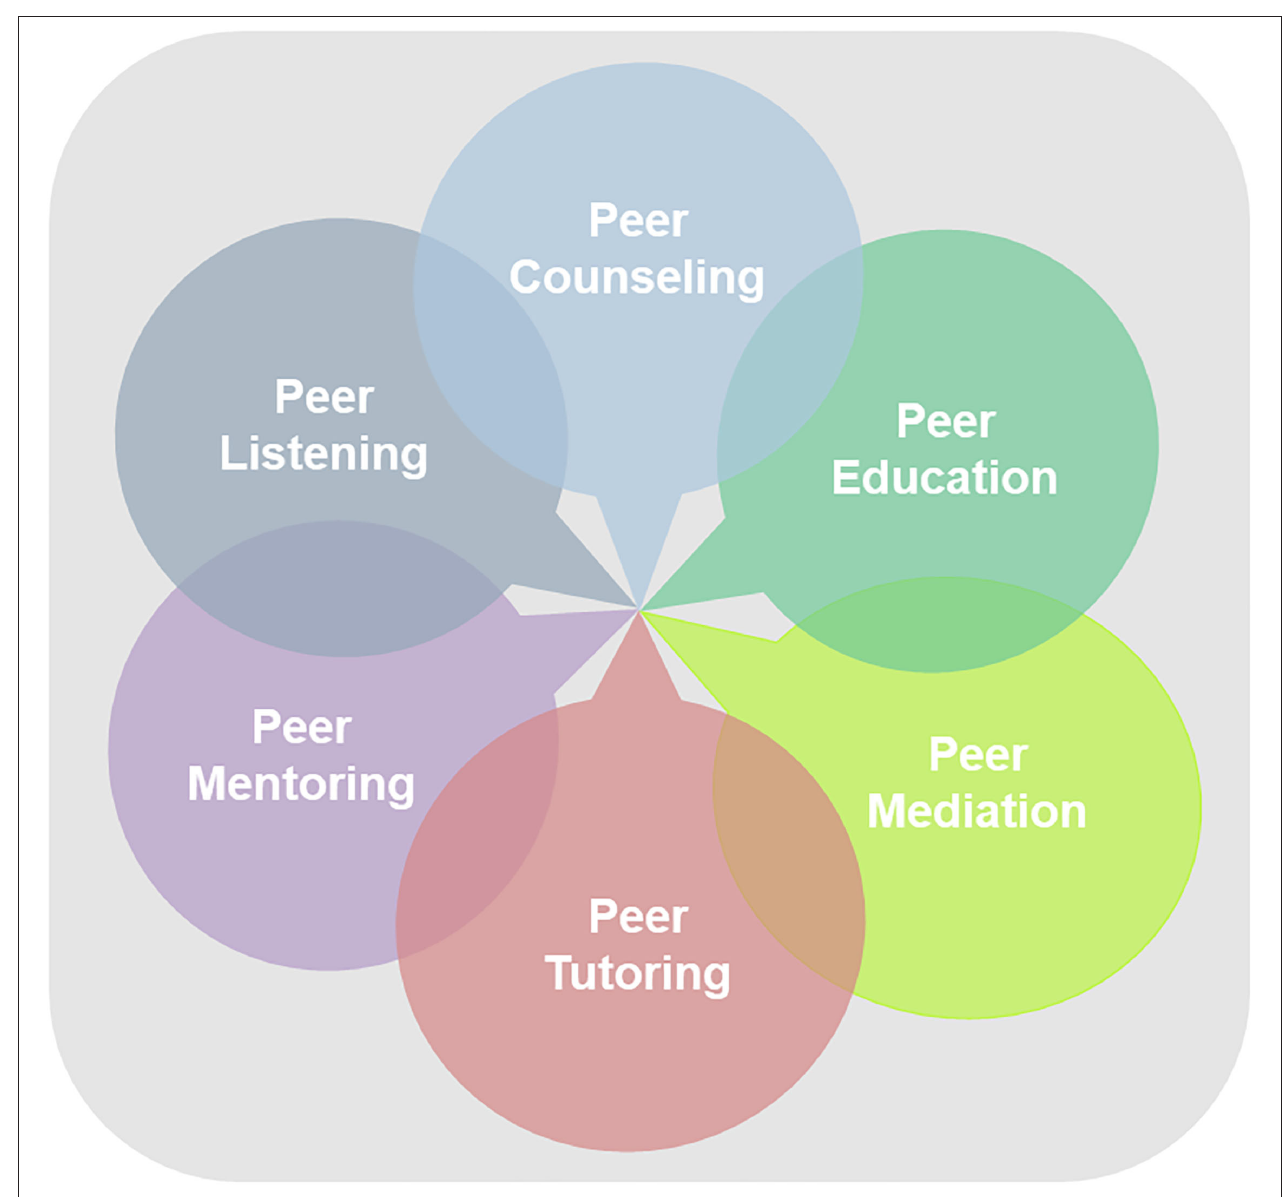
FIGURE 1 | Formats of Peer Support Offerings. In the interest of accessibility, here a complete description of the image: The picture shows a gray square with six circles containing different peer support services. The circles are in semi-transparent colors and overlap partly. With an arrow they all point to the center. On top (on 12 o’clock on a dial) the circle “Peer Counseling”, in the right upper quadrant (2 o’clock) “Peer Education”, in the bottom right quadrant (4 o’clock) “Peer Mediation”, down (on 6 o’clock) “Peer Tutoring”, in the bottom left quadrant (7 o’clock) “Peer Mentoring” and on the upper left quadrant (11 o’clock) “Peer